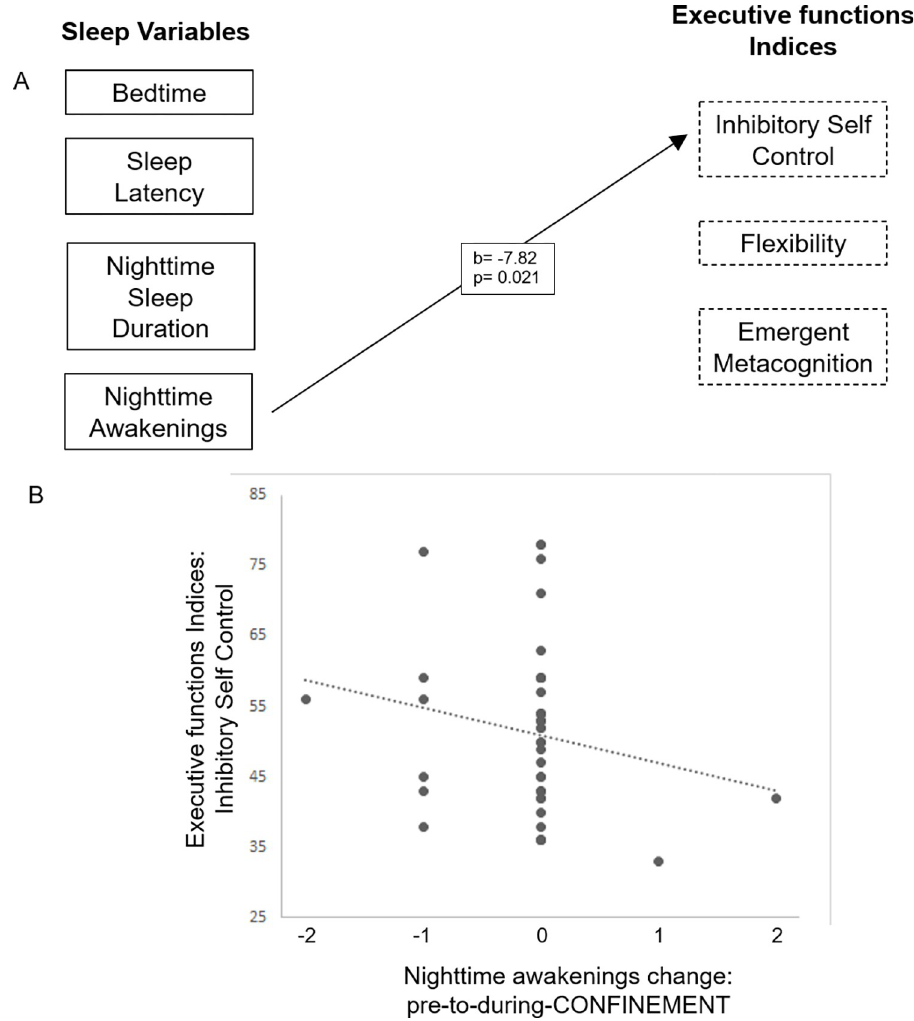
Fig 5. Prediction of executive functions indices by confinement-induced sleep behavior changes in young children. (A): The change in sleep is computed from subtraction pre-to-during-CONFINEMENT in each sleep behavior. Missing values indicate that sleep behavior did not survive the statistical backward selection, b indicates unstandardized beta coefficients, p represents corrected p-values from the linear mixed model. (B) Evolution of the change pre-to-during-CONFINEMENT of Nighttime awakenings and his association with the Inhibitory Self Control Indices. Dashed line automatically fitted with Excel software.